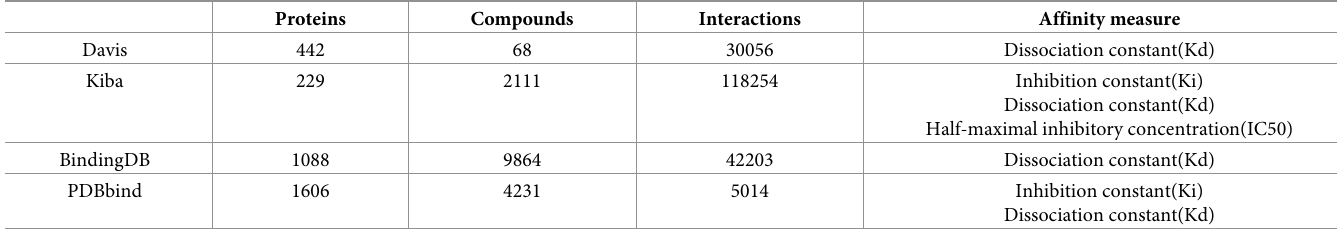
Table 12. The summary of benchmark